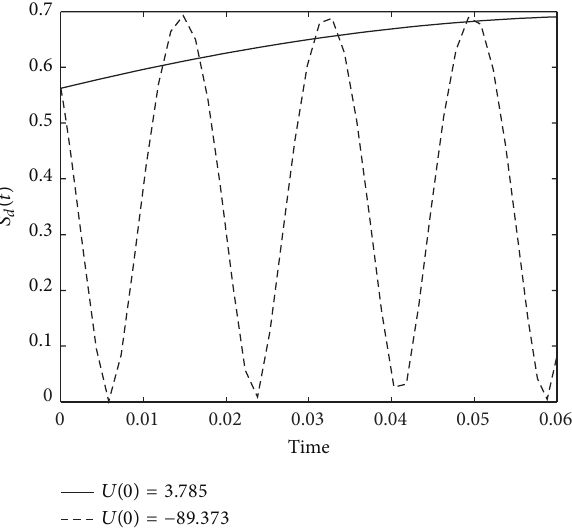
Figure 3: Evolutions of the entropy for system (69) with initial state 𝐶(0) = [√3/2, 1/2] 𝑇 under controller 𝑈(0) = 3.785 and −